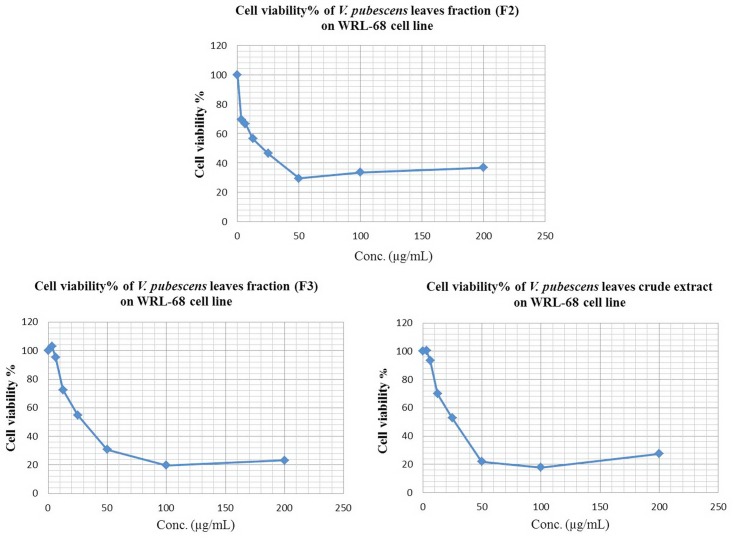
The effect of different concentrations of V. pubescens fraction (F2) on the viability of WRl-68.The Data (In triplicate) were expressed as mean ± SEM.